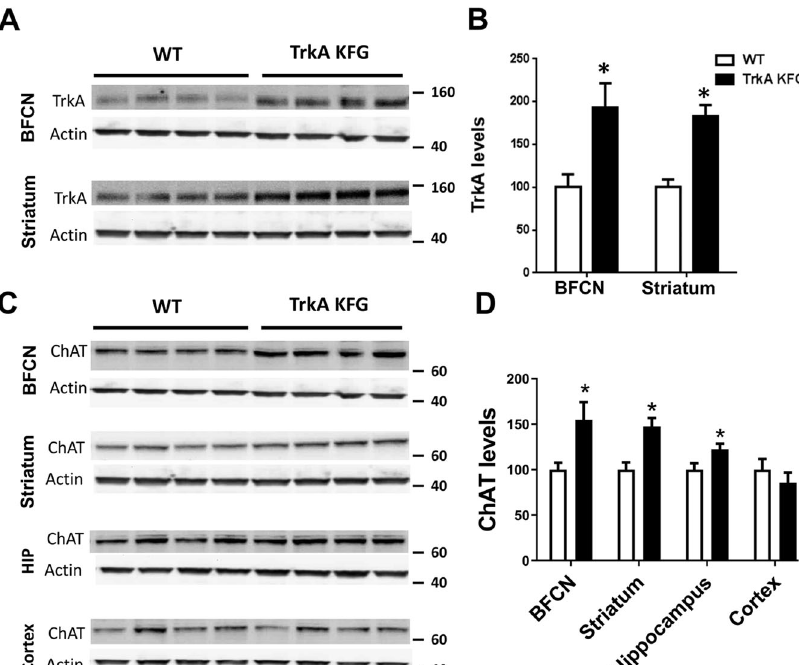
Fig. 1 TrkA-KFG mutant mice have increased CNS levels of TrkA and ChAT. Representative western blot images showing TrkA ( A ) and ChAT ( C ) protein levels in basal forebrain cholinergic neuron (BFCN) area, striatum, hippocampus (HIP), and cortex. Molecular weight markers in KD are on the right. Note the increased TrkA protein levels in BFCN and striatum of TrkA-KFG mutant mice ( A , B ). Levels of ChAT protein are increased in BFCN, striatum, and hippocampus but not in cortex ( C , D ). Actin was used as loading control. Histograms ( B , D ) show results of quantitative analysis of band intensity in both genotypes. N = 8 per genotype; * p < 0.05 by Student ’ s t